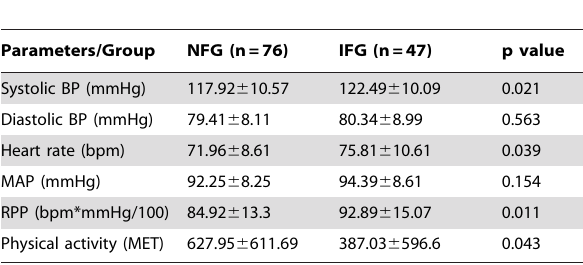
Table 2. Comparison of resting (sitting)